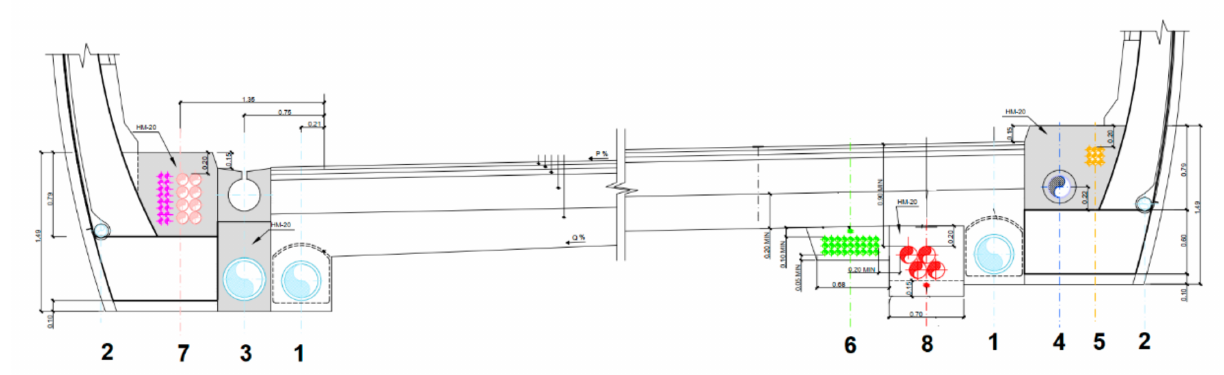
Figure 4. Main ducts of the Arnotegi tunnel (1: seepage water collector; 2: drain pipe; 3: